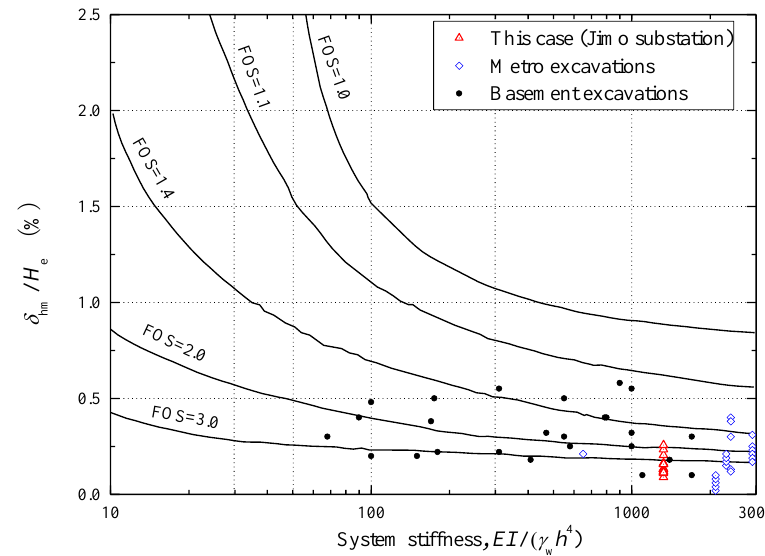
Figure 11. Normalized maximum wall deflections versus system stiffness.